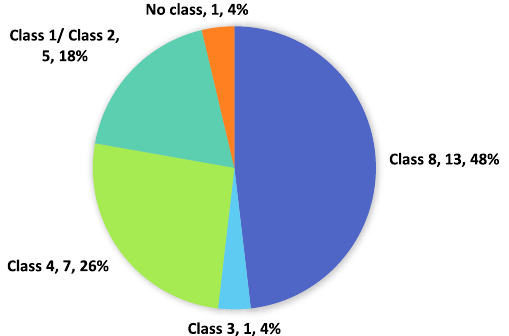
Fig. 3. Classification of putative R-genes in qBFR4 according to relevant